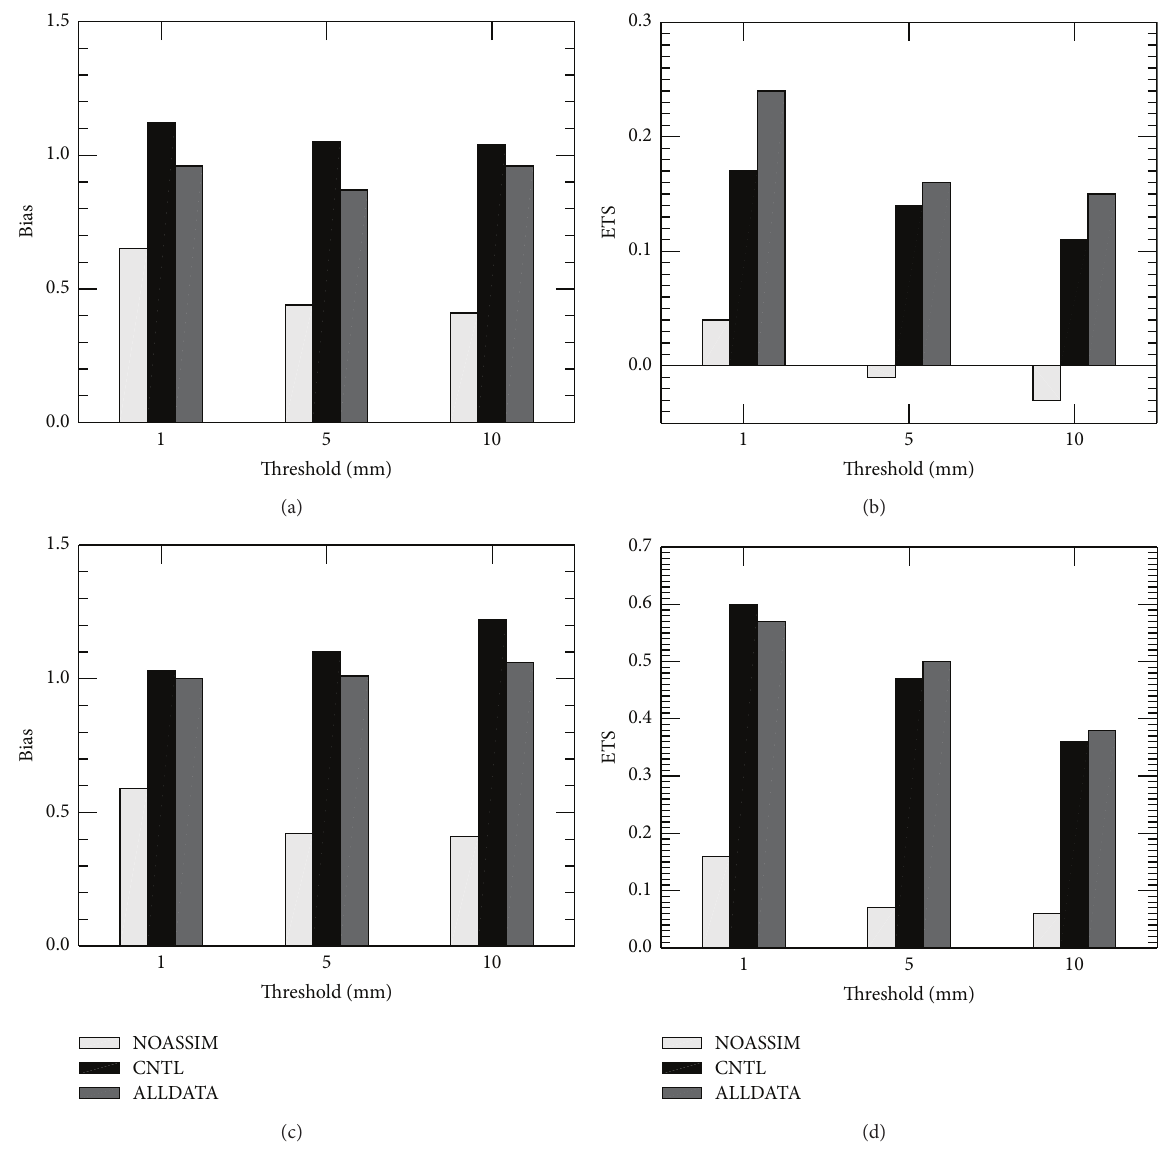
Figure 15: Bias score and ETS for 12h accumulated precipitation with the thresholds of 1, 5, and 10mm from NOASSIM, CNTL, and ALLDATA. (a) Bias and (b) ETS for case 20110629 and (c) bias and (d) ETS for case